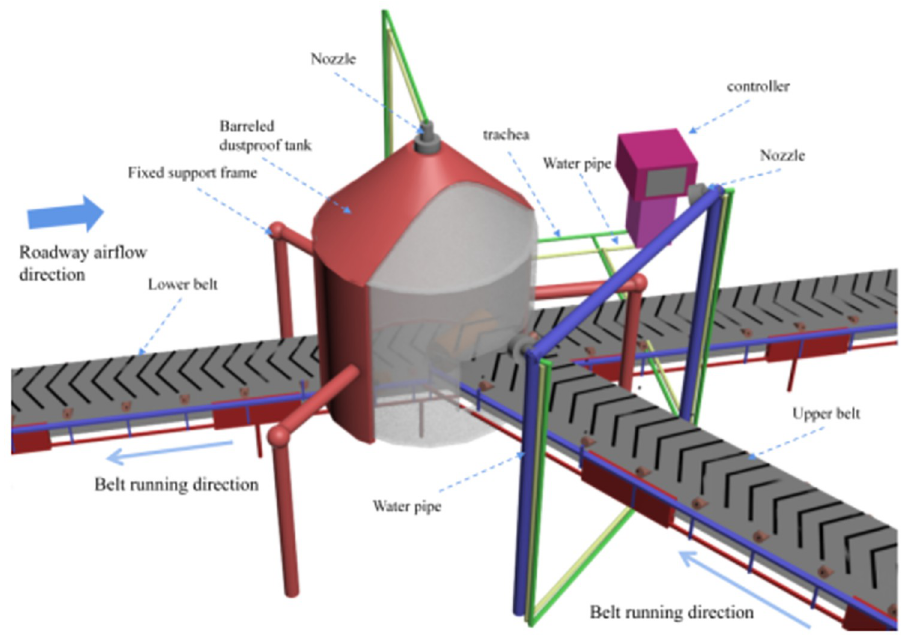
Fig 3. Installation of pneumatic screw spray and dust removal